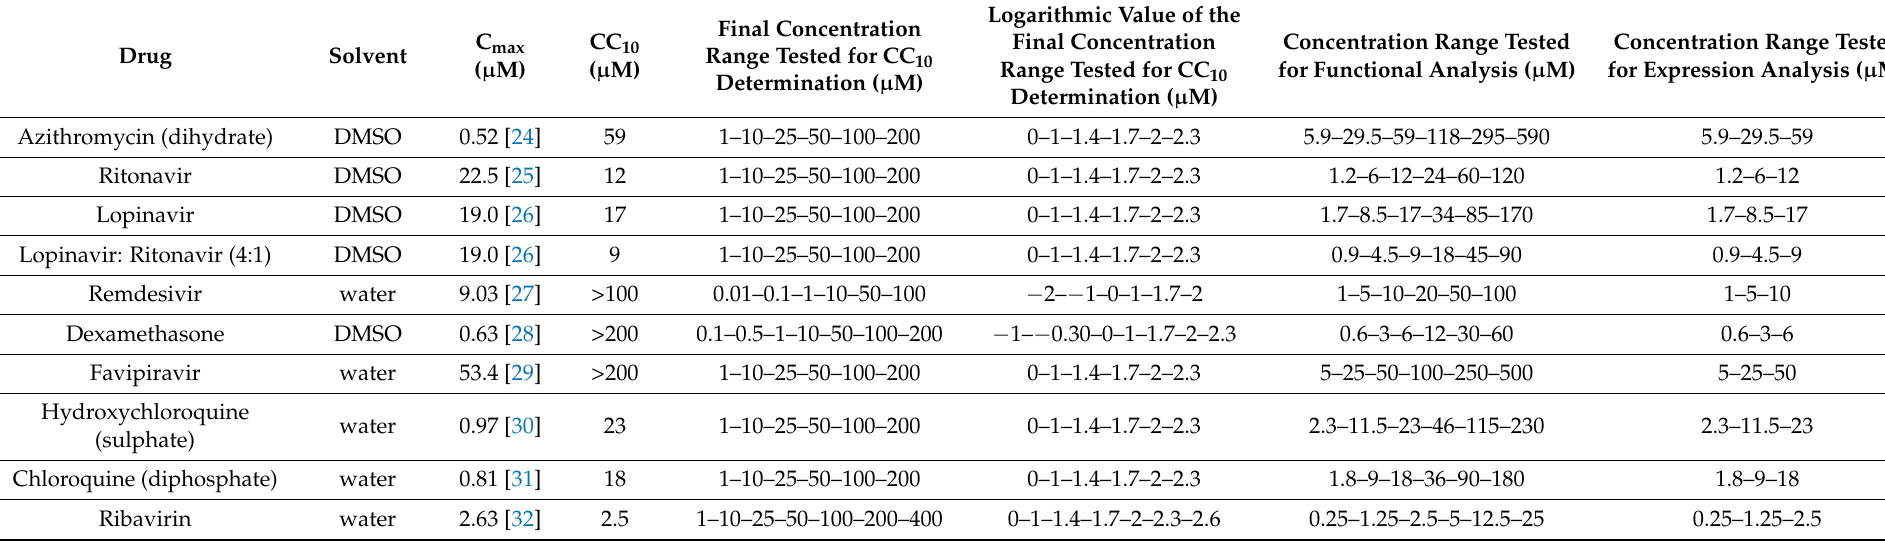
Table 1. Panel of drugs and drug combinations tested in the present study: DMSO, dimethyl sulfoxide; RT-qPCR, real-time quantitative reverse-transcription polymerase chain reaction analysis; C max , maximum plasma concentration extracted from literature and recalculated to values in µ M. References are cited between square brackets behind their respective C max value; CC 10 , concentration inducing 10% of cell